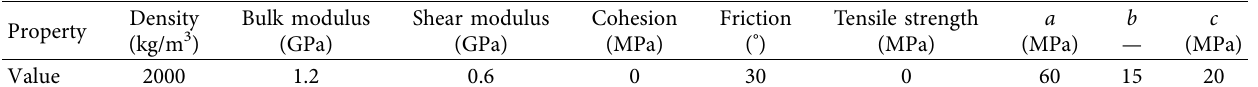
Table 3: Gob material properties.